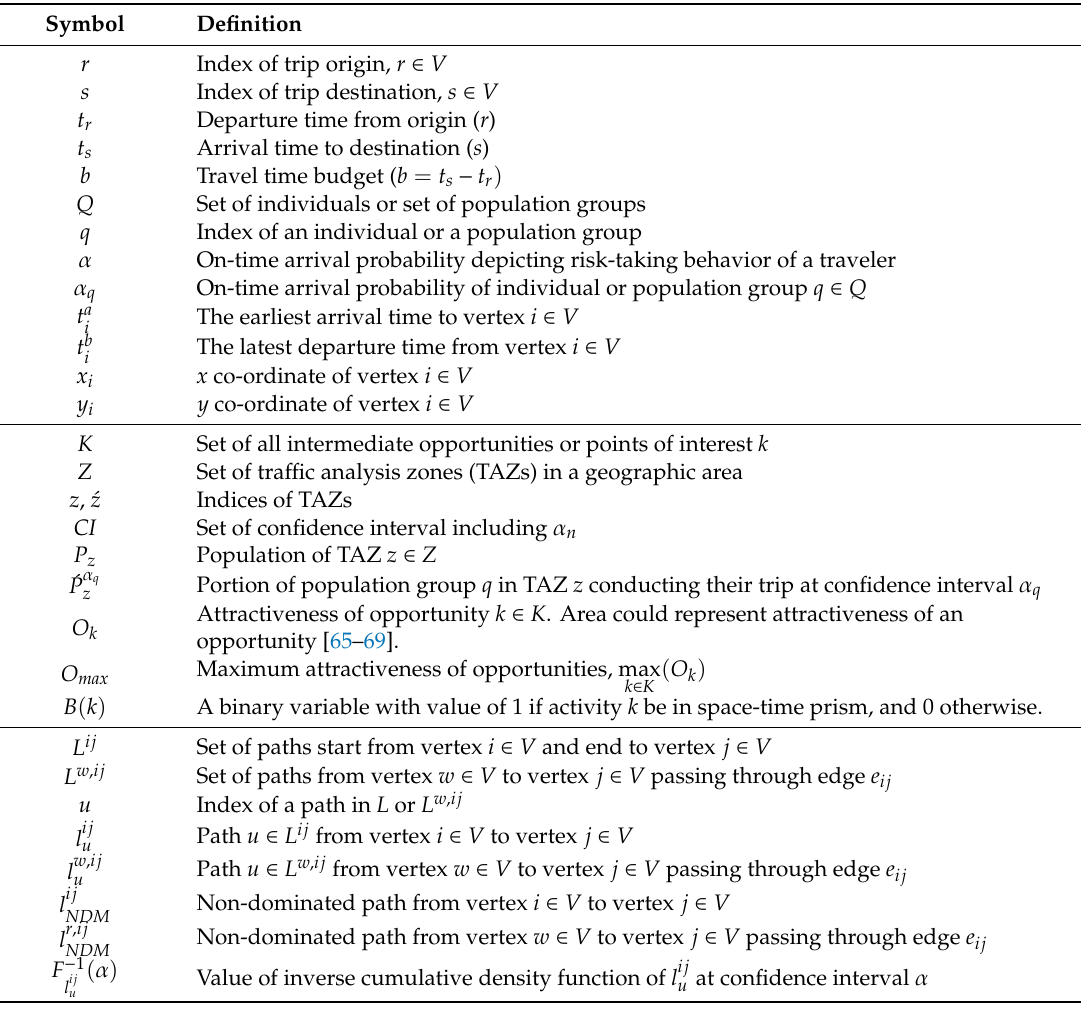
Table 1. Parameters used in model